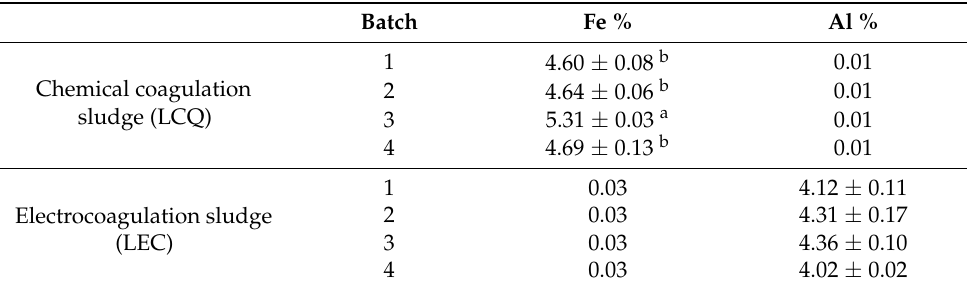
Table 2. Composition of Fe and Al (dry base) in sludge flour from